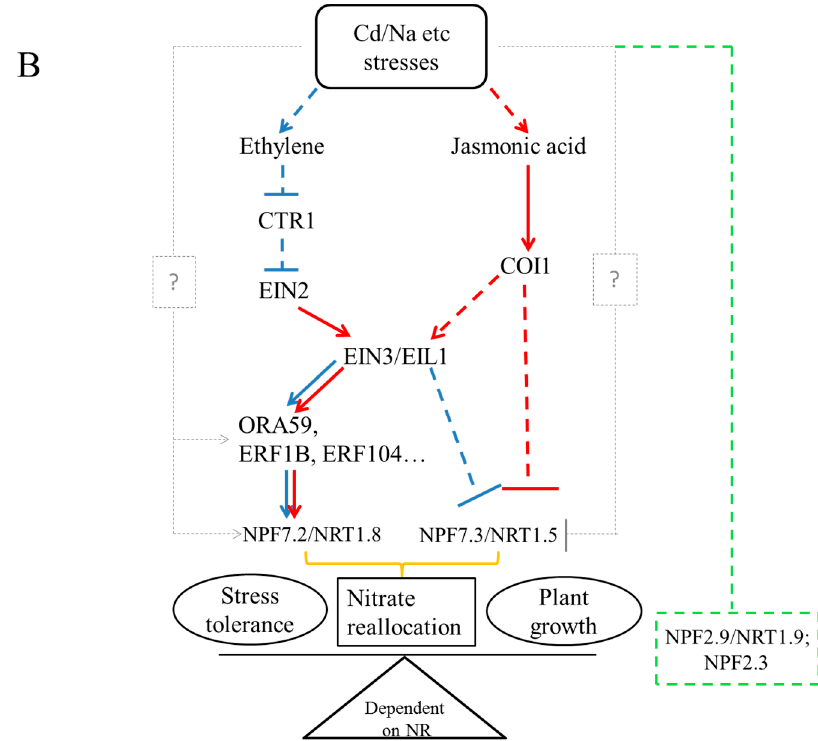
Figure 1. ( A ) The localization of nitrate transporters related to nitrate long-distance transport and ( B ) the regulation of stress-initiated nitrate allocation to roots (SINAR) by ethylene/jasmonate (ET/JA) signaling pathways to mediate plant adaptation to the environments. For ( B ), blue lines display the route for signals going through the ET signaling pathway, while red lines indicate those through the JA signaling pathway. Dashed lines indicate steps not shown or possible unidentified components. Gray dotted lines and question marks indicate alternative pathways/components that contribute, but to a much lesser extent, in the regulation of AtNPF7.3/AtNRT1.5 and AtNPF7.2/AtNRT1.8. In the stressed conditions, the expression of AtNPF2.3 and AtNPF2.9/AtNRT1.9 was unchanged, indicated by green lines and box. Note that ( A ) was revised from Figure 2 in [7] and ( B ) was revised from Figure 10 in [30]. The allocation of nitrate between roots and shoots is not only through xylem but also